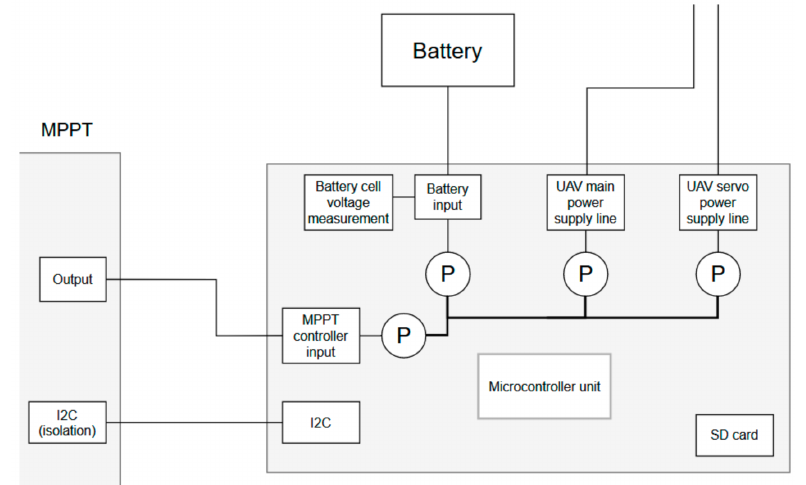
Figure 11. Block schematic of the MPPT in connection with the logger.